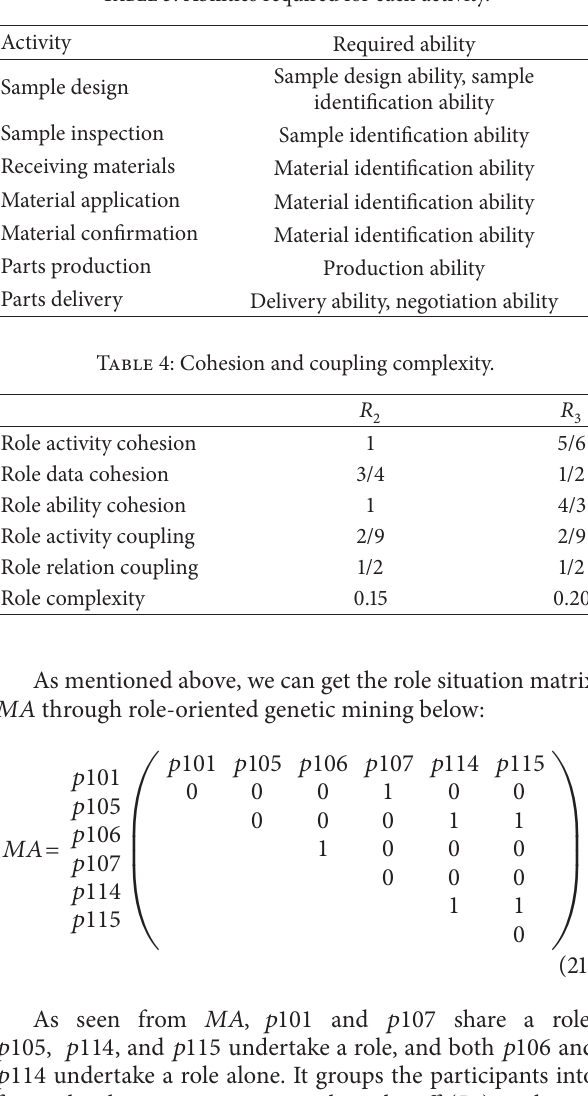
Table 2: Data required for each activity. Table 3: Abilities required for each activity.